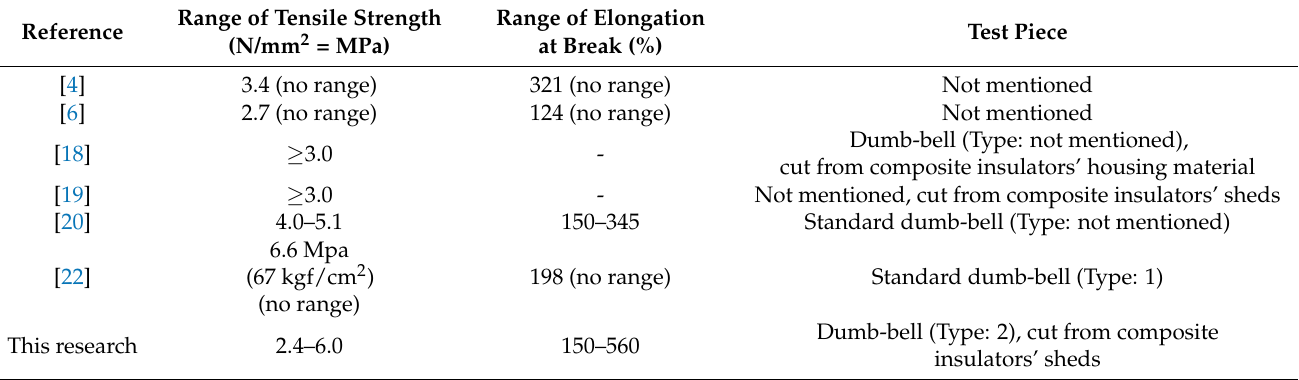
Table 4. Comparative study and contribution to the range of tensile strength and elongation at break on new (unused) HTV silicone rubber with ATH filler used as composite insulators’ housing material and the corresponding types of test pieces